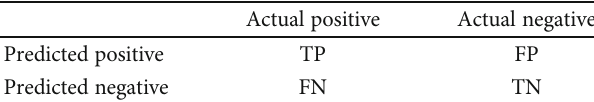
Table 1: Confusion